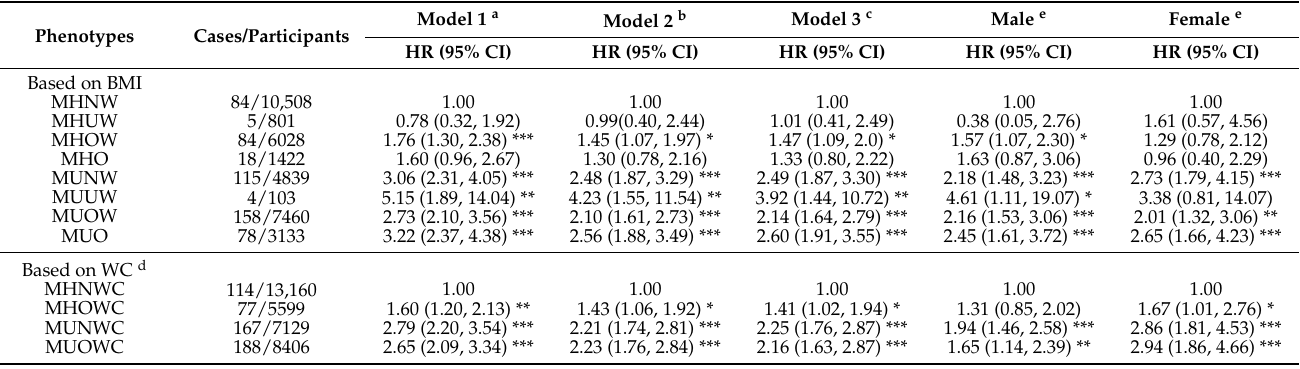
Table 2. Hazard ratios for stroke according to metabolic phenotypes defined by BMI or WC.